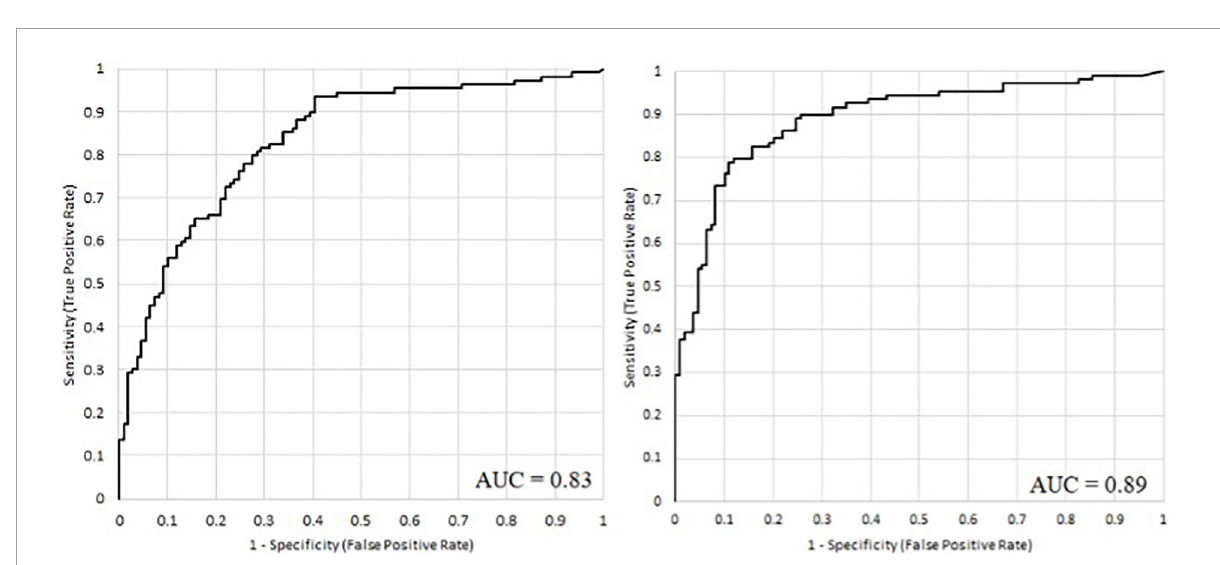
FIGURE6 The ROC curve of the acoustic models when models were trained with BDI (left) and with H2B scores (right) .